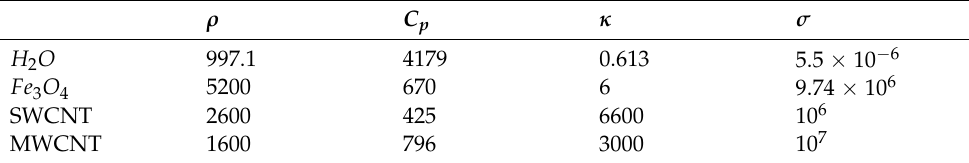
Table 1. The thermophysical properties of water base fluid and hybrid nanoparticles.